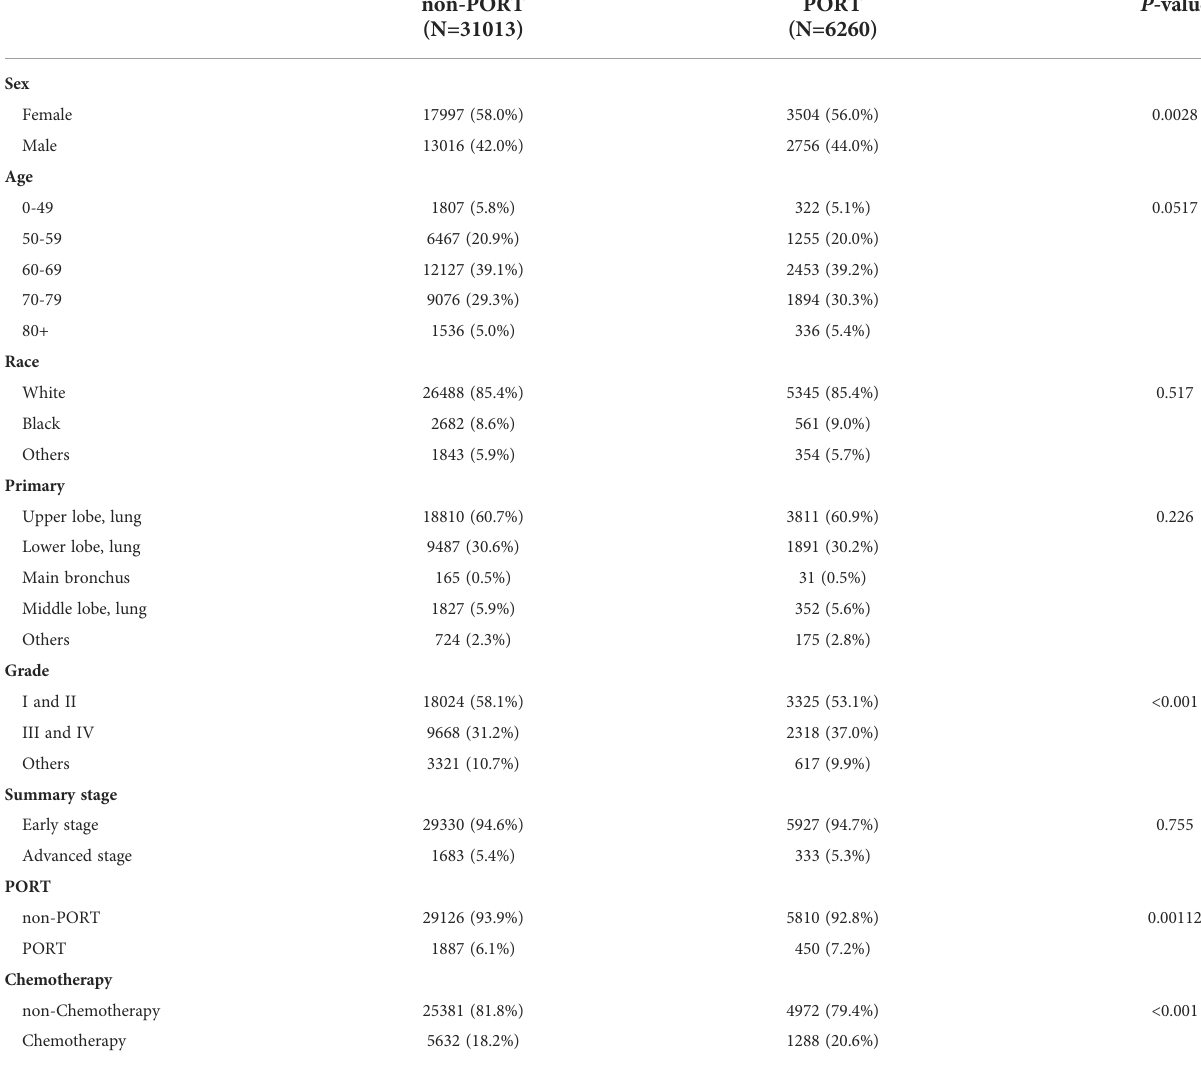
TABLE 1 All Patients after propensity score matching, strati fi ed by Second Primary Lung Cancer (SPLC) vs. Initial Primary Lung Cancer